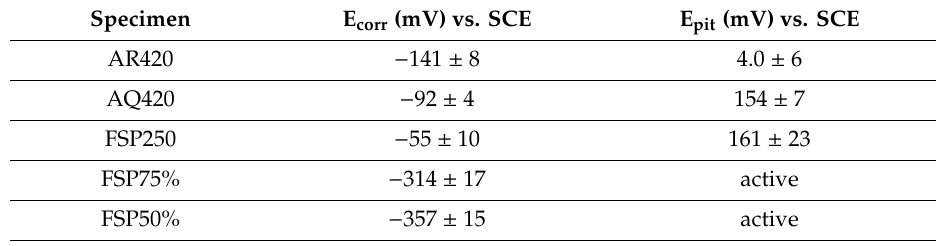
Table 2. Corrosion parameters of various specimens. SCE—saturated calomel electrode; AR420— annealed 420; AQ420—conventional hardened 420; FSP—friction stir processing.